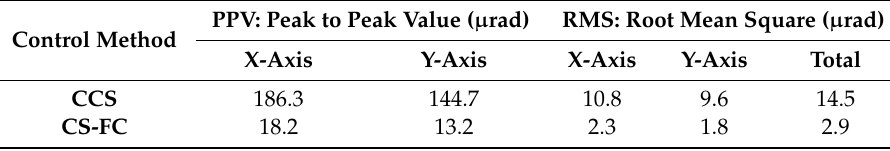
Figure 9. Shipboard ETOS LOS stabilization error( X -axis and Y -axis). ( a ) stabilization error of CCS; ( b ) stabilization error of CS-FC. Table 2. Shipboard LOS stabilization error of CCS and CS-FC.